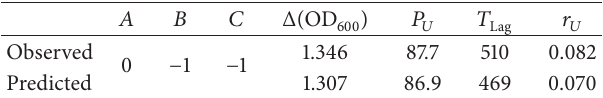
𝑃 𝑇 𝑟 600 ) 𝑈 𝑈 Lag 1.346 87.7 510 0.082